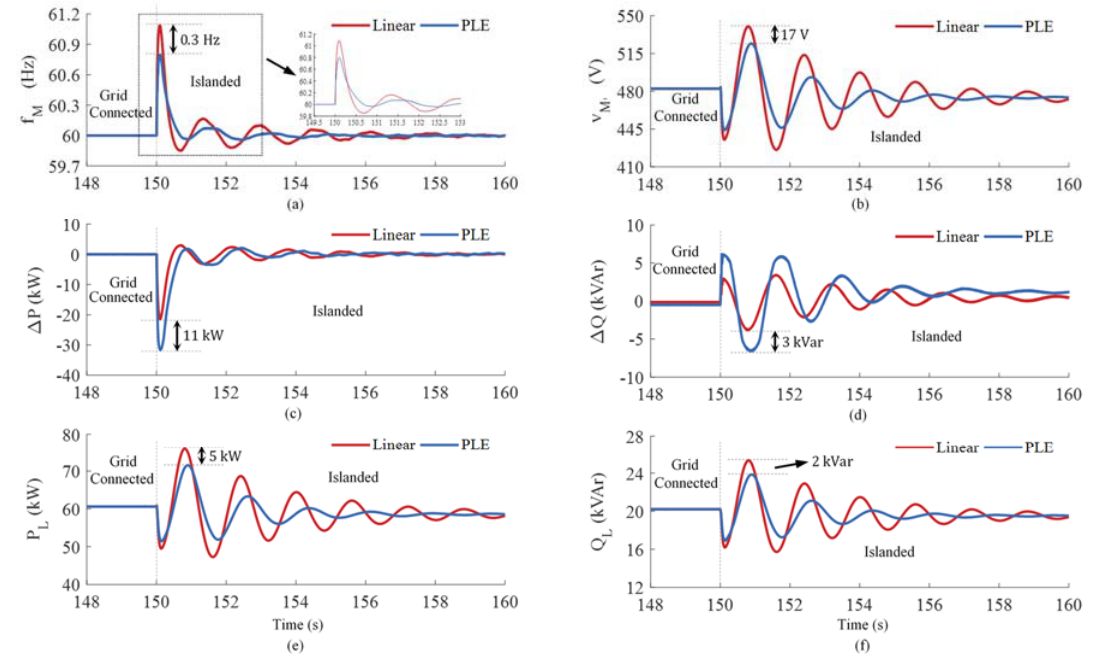
Figure 8. Comparing the performance of linear and PLE droops in the dynamic ‐ response enhancement of the system during the transition from grid ‐ connected to islanded mode: ( a ) AC ‐ bus frequency; ( b ) AC ‐ bus voltage; ( c ) BESS active power; ( d ) BESS reactive power; ( e ) load active power and ( f ) load reactive power. Table 3. Dynamic performance comparison of linear and PLE droops during transition from grid-connected to islanded mode. With Linear With PLE Settling Time Over Shoot Settling Time Over Shoot f M 7 s 1.1